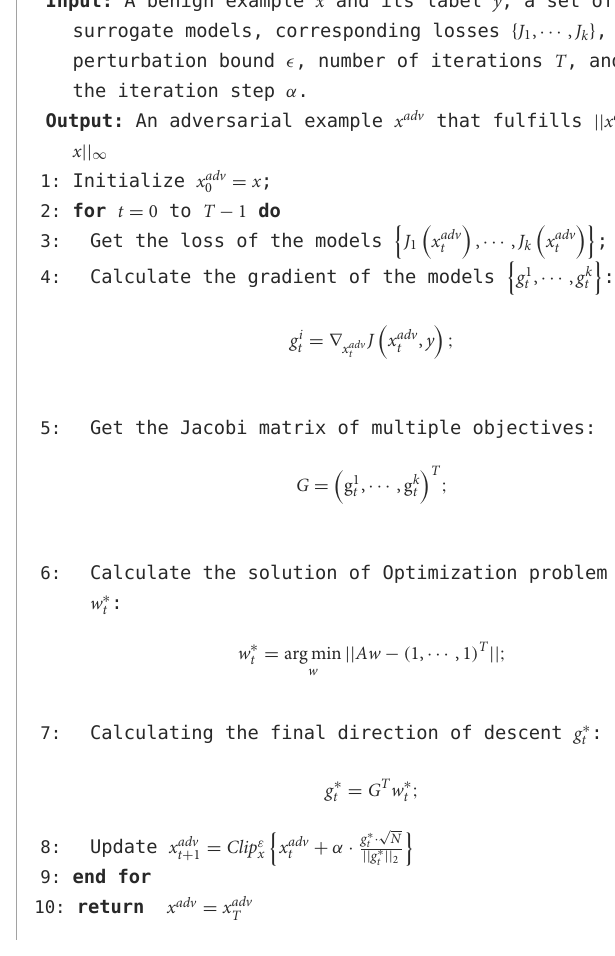
Algorithm 1. The RGEA-I-FGSM attack